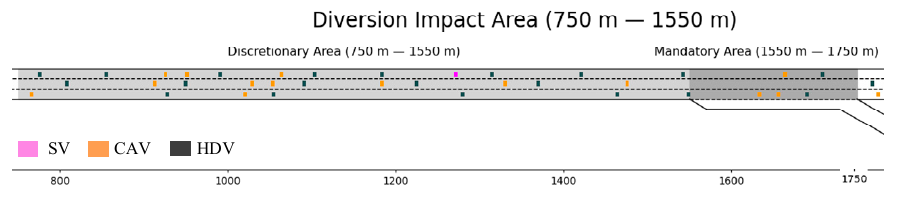
Figure 5. Traffic simulation environment.